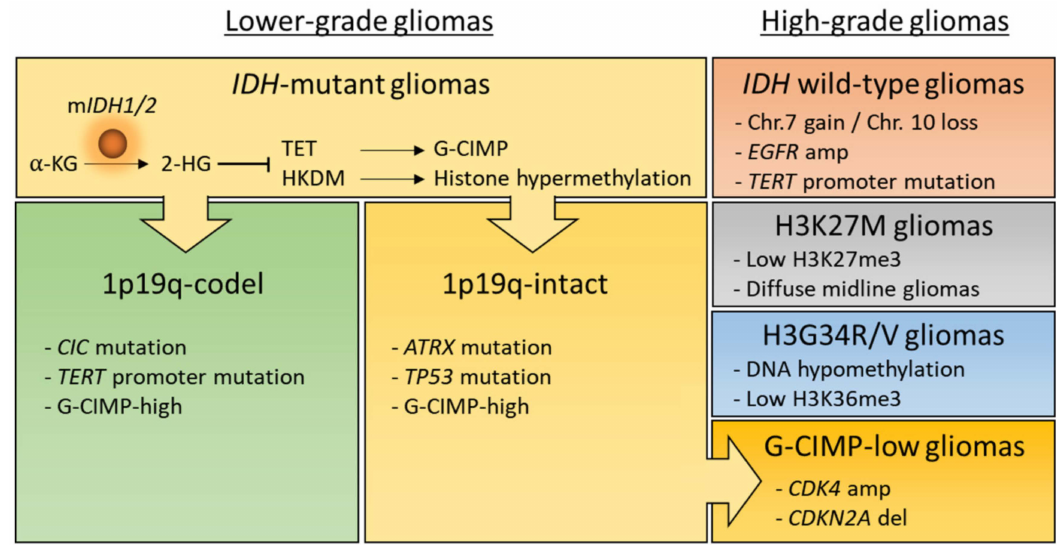
Figure 1. Major subtypes of adult and pediatric gliomas. According to isocitrate dehydrogenase ( IDH ) status, adult di ff use gliomas are largely classified into two subgroups, IDH -mutant or wild-type gliomas. Lower grade or IDH -mutant gliomas are further classified into two subtypes, 1p19q-codel or -intact gliomas. Importantly, loss of DNA methylation in IDH -mutant and 1p19q-intact gliomas during malignant recurrence may involve the progression to high-grade G-CIMP-low gliomas. 2-HG, D-2-hydroxyglutarate; α -KG, α -ketoglutarate; Chr, chromosome; G-CIMP, glioma-CpG island methylator phenotype; H3, Histone 3; HKDM, histone lysine demethylase; m IDH1 / 2 , mutant IDH1 / 2 ; TET, ten-eleven translocation